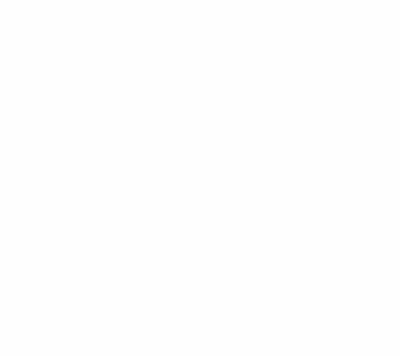
Fig. 4: Apparent biaxial extensional viscosity, 11 be . versus Hencky strain, £h, at a constant biax­ ial strain rate for doughs of the eleven wheat